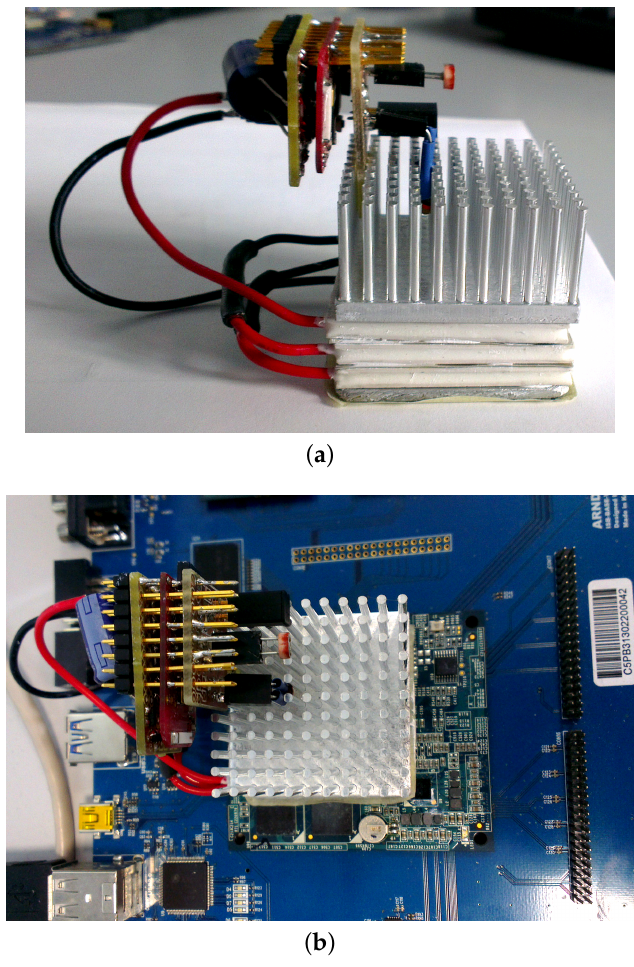
Figure 1. Pictures of the system prototype. ( a ) Side view of the TEG with heat sink, sensors, and transceiver board; ( b ) Top view of the system prototype mounted on top of the target CPU